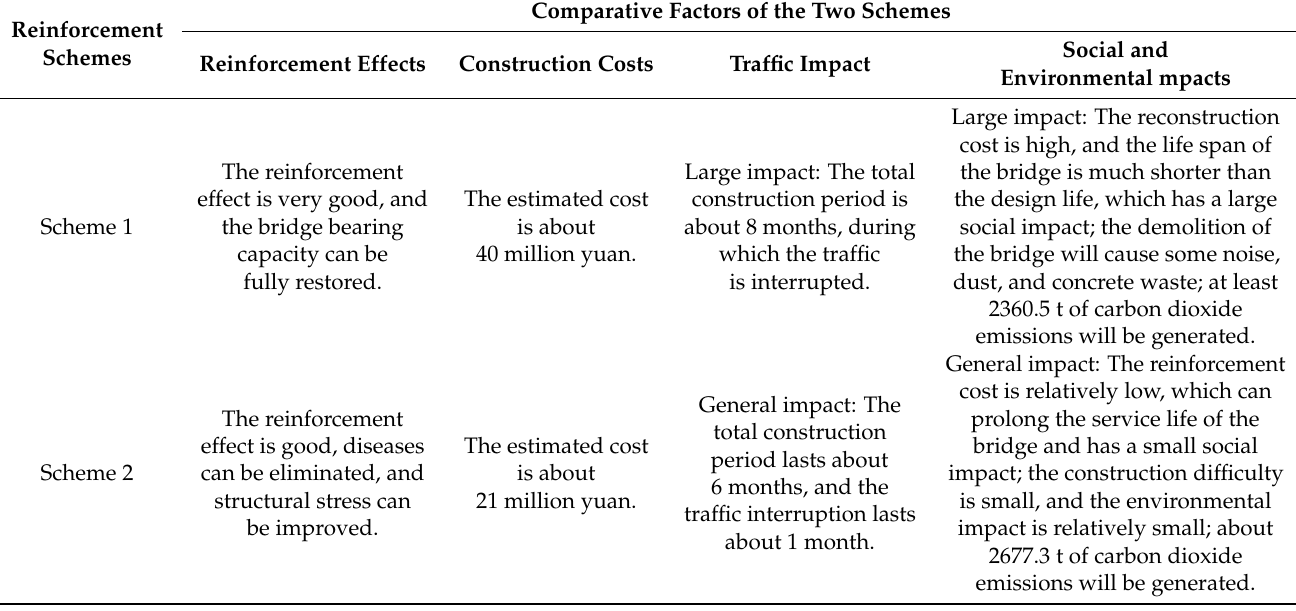
Table 3. Comparative analysis of reinforcement